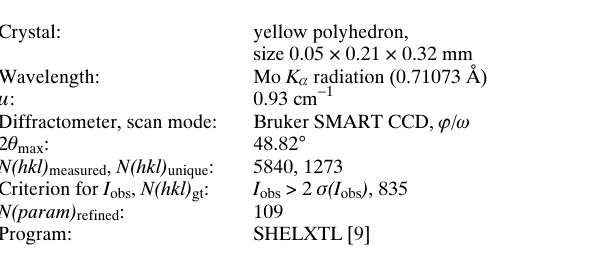
Table 3. Atomic coordinates and displacement parameters (in Å 2 ) .